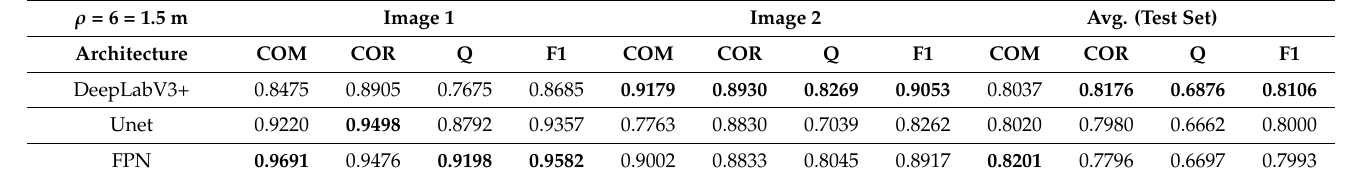
Table 8. Rural road extraction quantitative results for a ρ = 6 (using the Guo–Hall thinning algorithm). Table 7. Rural road extraction quantitative results for a ρ = 4 (using the Guo–Hall thinning algo- rithm).